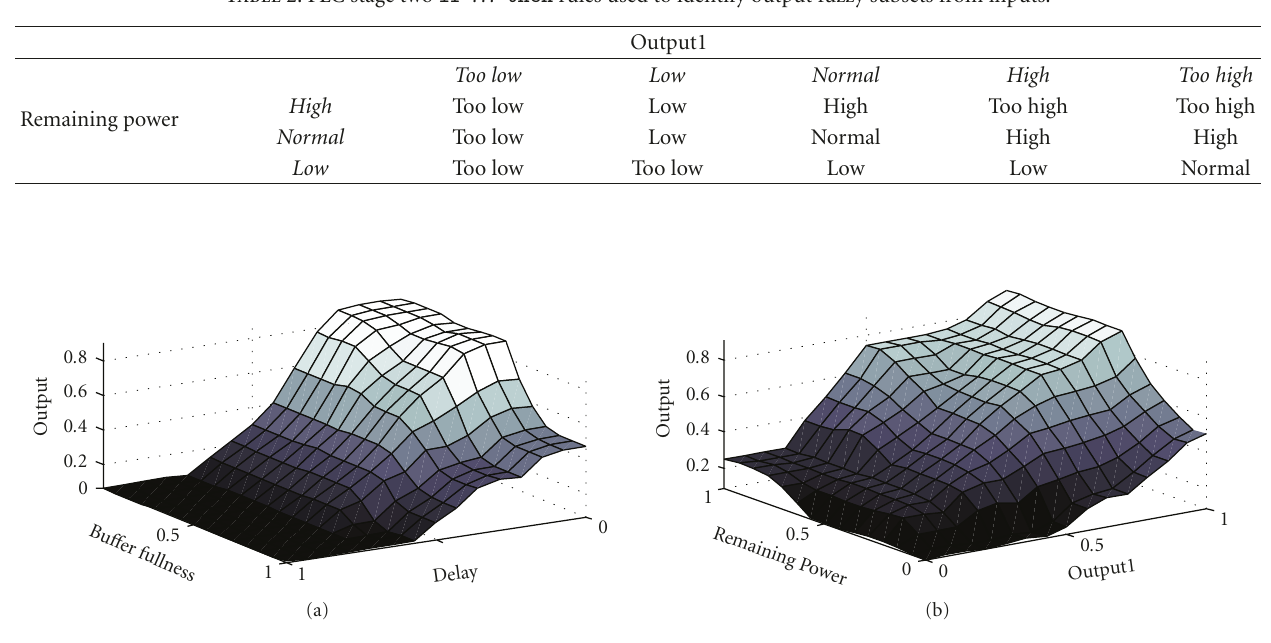
Table 2: FLC stage two if ... then rules used to identify output fuzzy subsets from inputs.